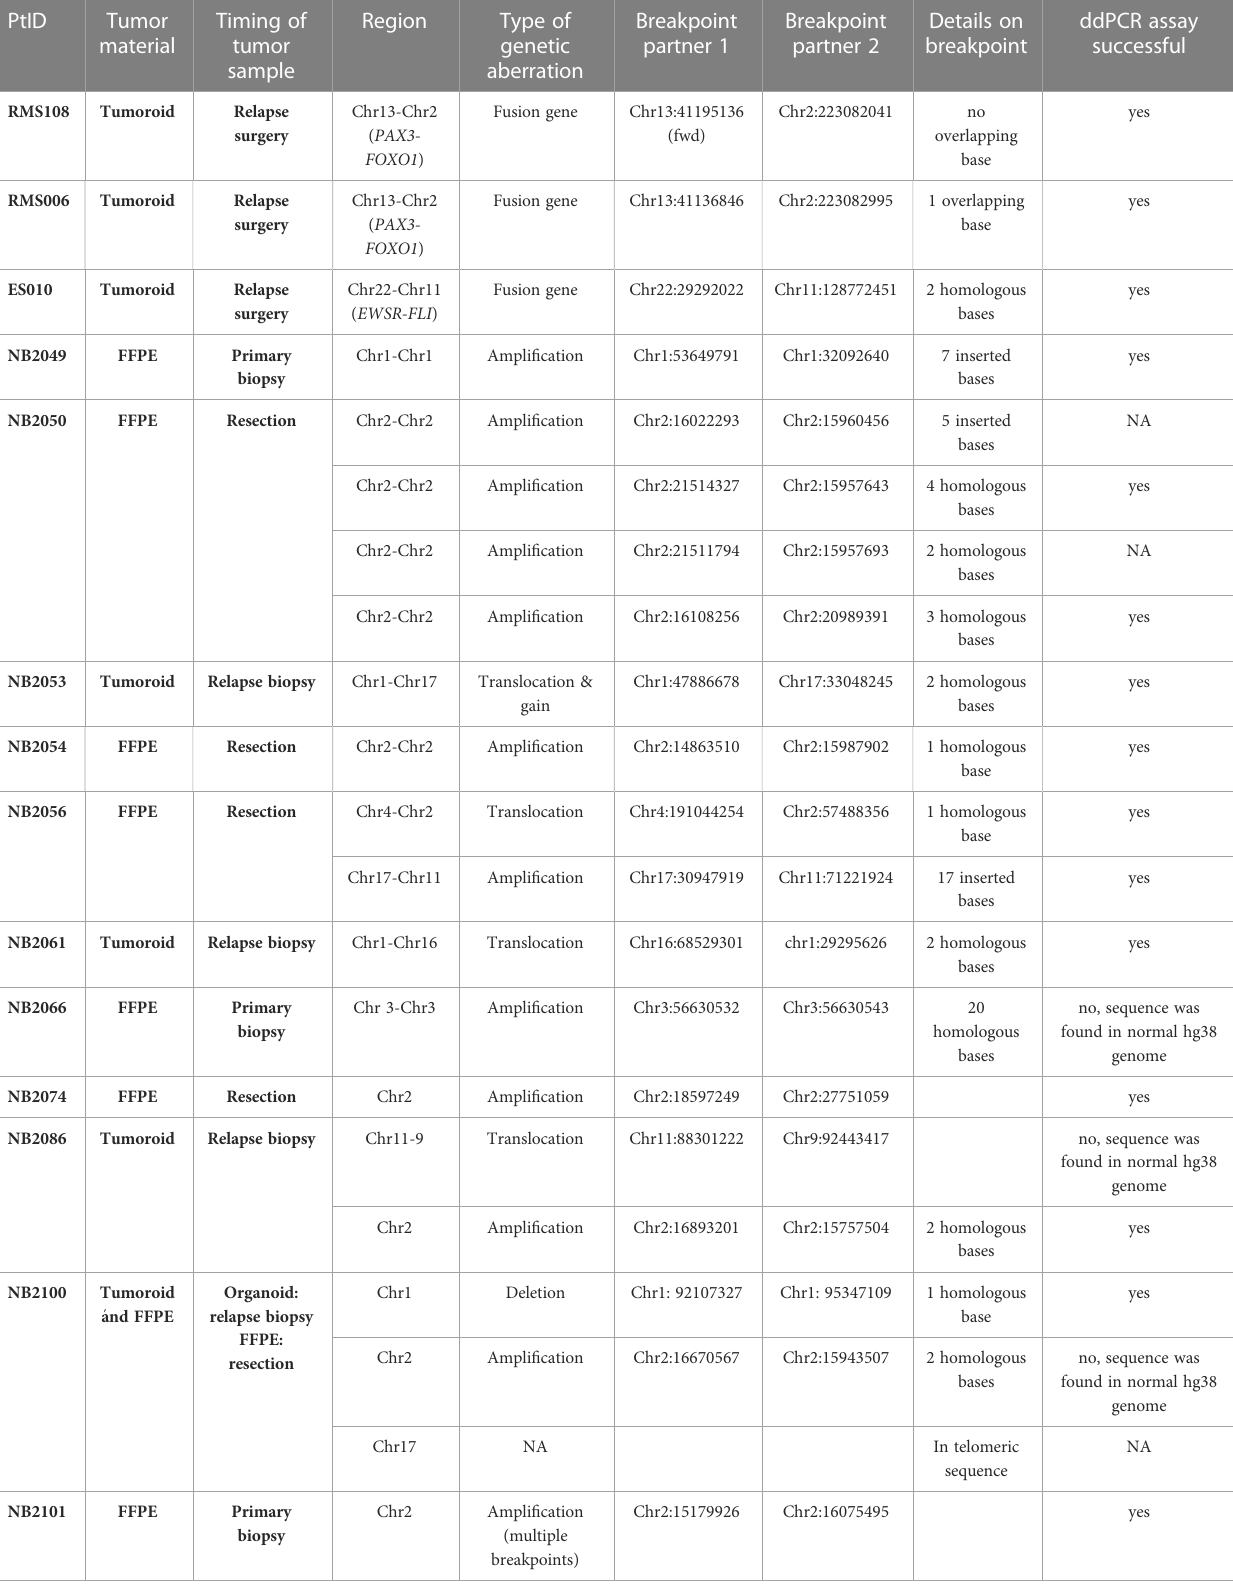
TABLE 2 Overview of tumor material and